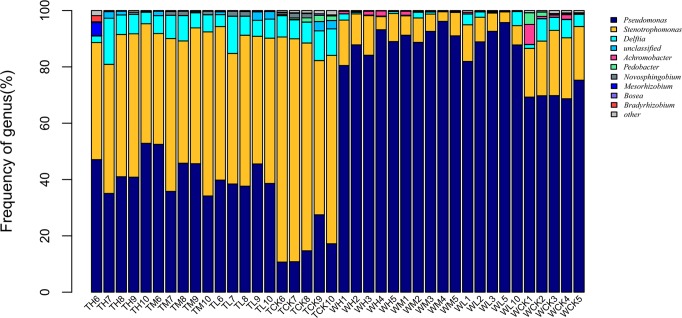
Bacterial composition at the genus level.WH1-5, WM1-5, WL1-3,5,10, and WCK1-5 denote the antibiotic-untreated PWNs receiving the three different levels of α-pinene, as well as the control group (WCK1-5). TH6-10, TM6-10, TL6-10, and TCK6-10 denote the antibiotic-treated PWNs receiving the three different levels of α-pinene, as well as the control group (TCK6-10).